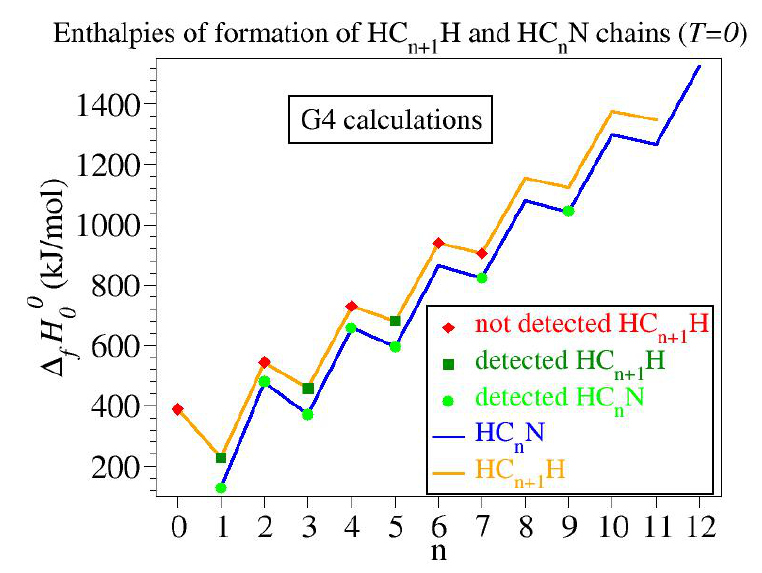
Figure A1. Enthalpies of formation ∆ f H 0 comparison between the isoelectronic chains HC n +1 H and HC n